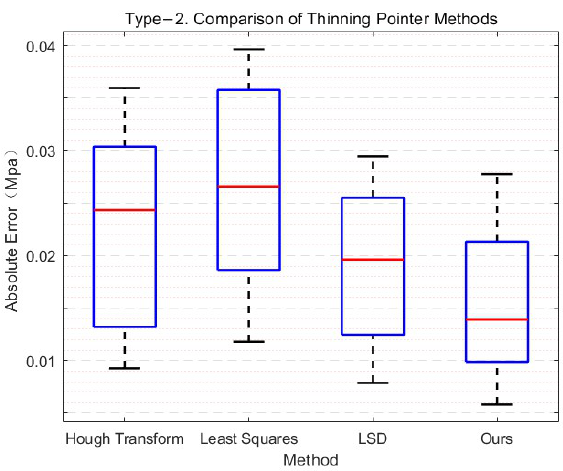
Figure 11. Robustness testing of refined needle methods.